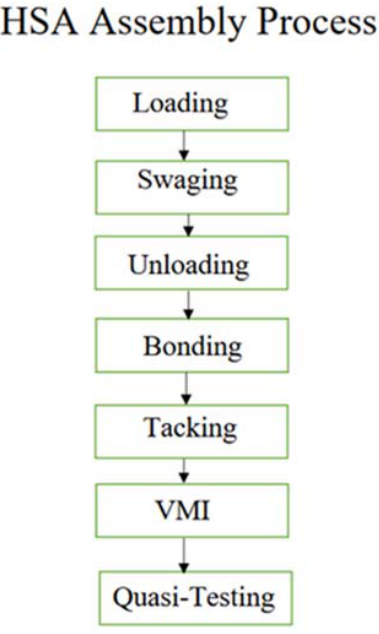
Figure 9. Head stack assembly process used in the hard disk.